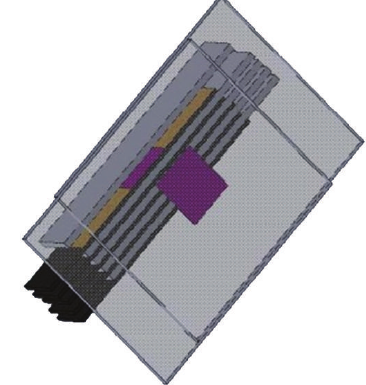
Figure 3: Schematic diagram of tandem DSSC